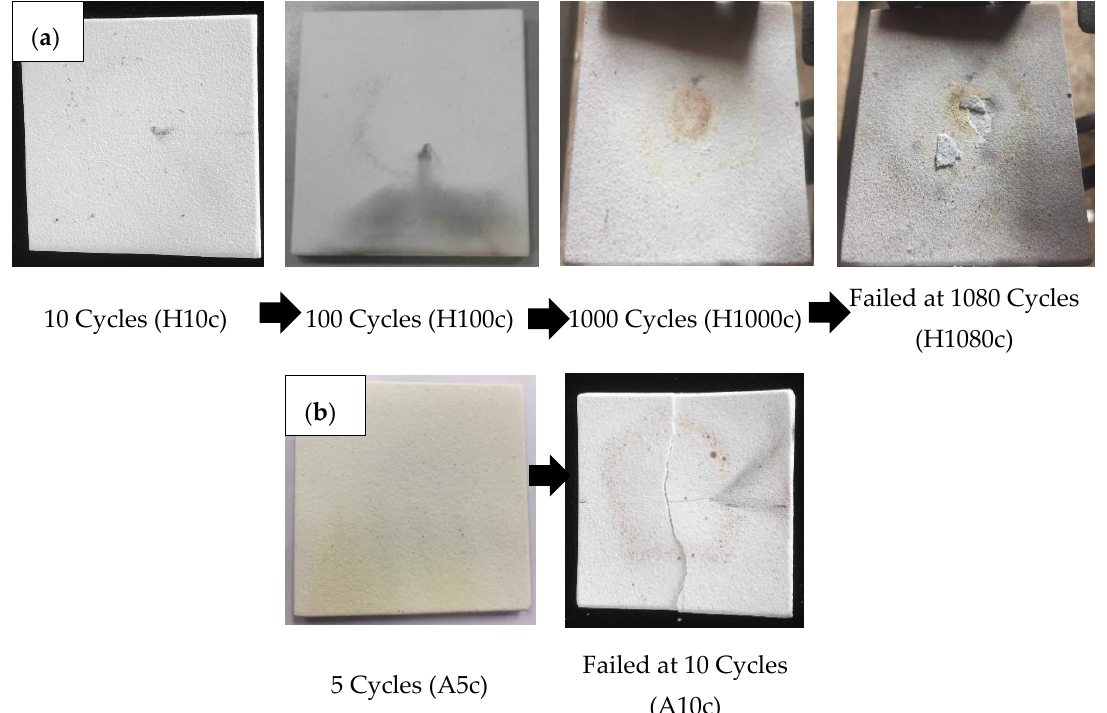
Figure 1. Process of TBC failure by thermal cycle test for ( a ) HVOF and ( b ) APS bondcoats.